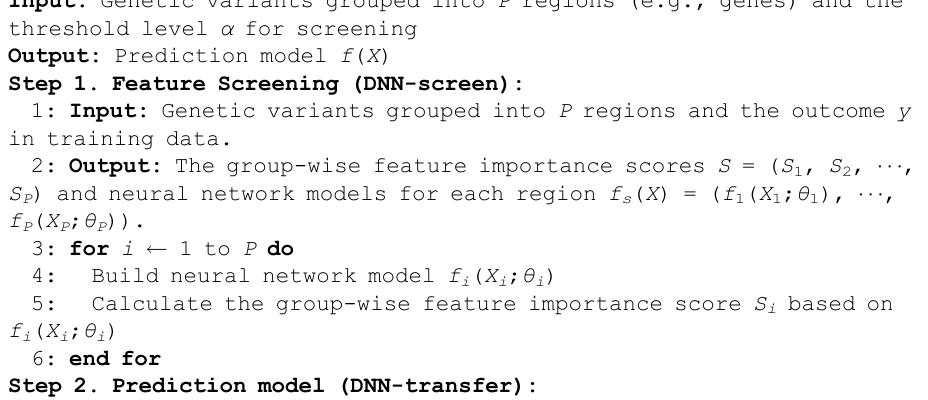
Algorithm 1 Deep Neural Network-based Prediction